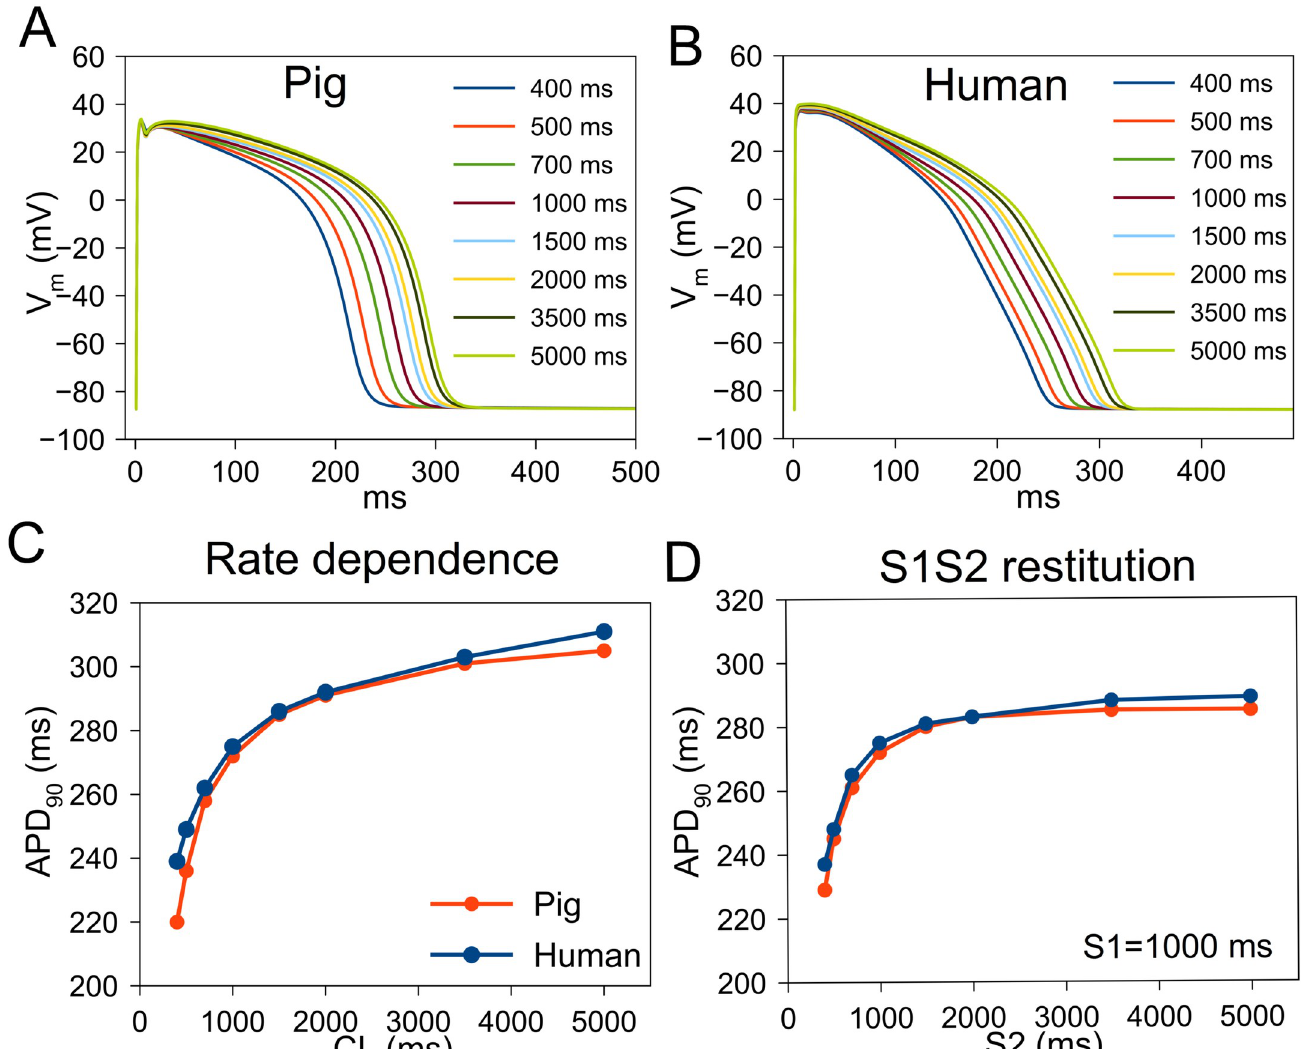
Fig 5. Steady-state rate dependence (also called adaptation) and restitution of action potential (AP) duration (APD) in human and pig ventricular myocyte. (A) Steady-state pig action potential (AP) at cycle length (CL) 400–5000 ms. (B) Human AP at CL 400–5000 ms. (C) Adaptation of APD at 90% repolarization (APD 90 ) in pig and human. (D) APD restitution in pig and human. The driving (S1) CL is 1000 ms followed by varying pacing intervals (S2).